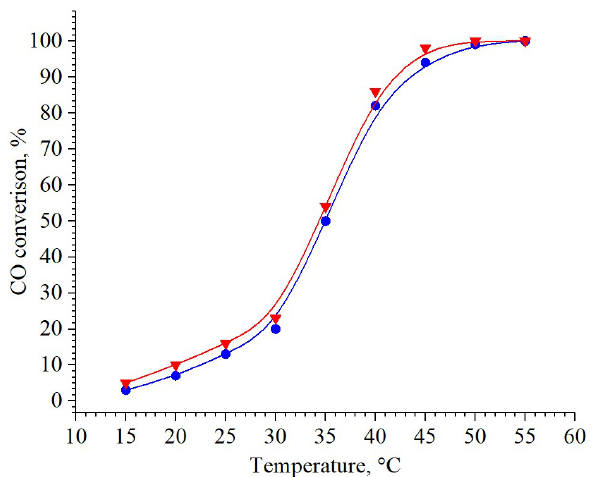
Figure 5. CO conversion vs oxidation reaction temperature in a mixture of 16.9% O 2 , 62.4% N 2 and 20.7% CO at a flow rate of 120,000 h − 1 ; first run (blue curve) and third run (red curve). The molar ratio of O 2 /CO = 0.82.